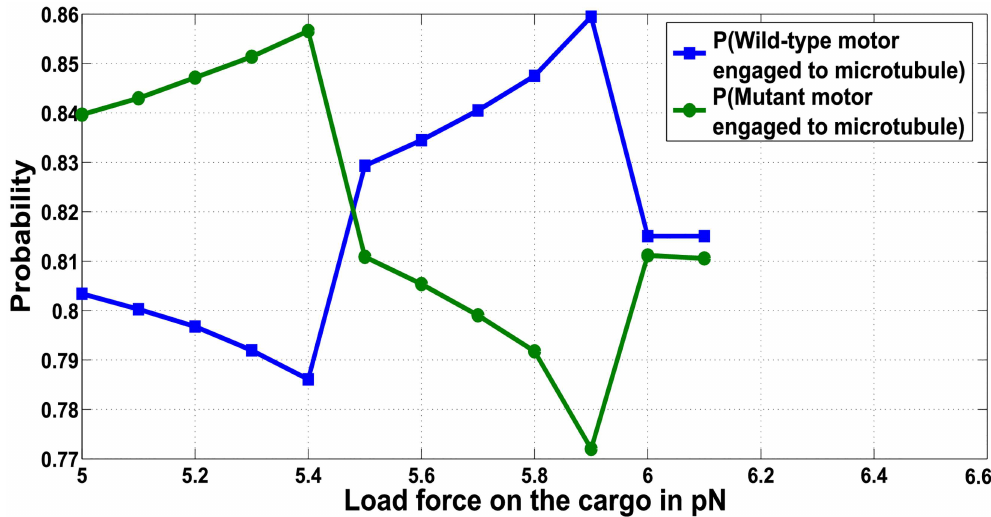
Fig 11. Probability of wild-type and mutant motor being attached for ensemble